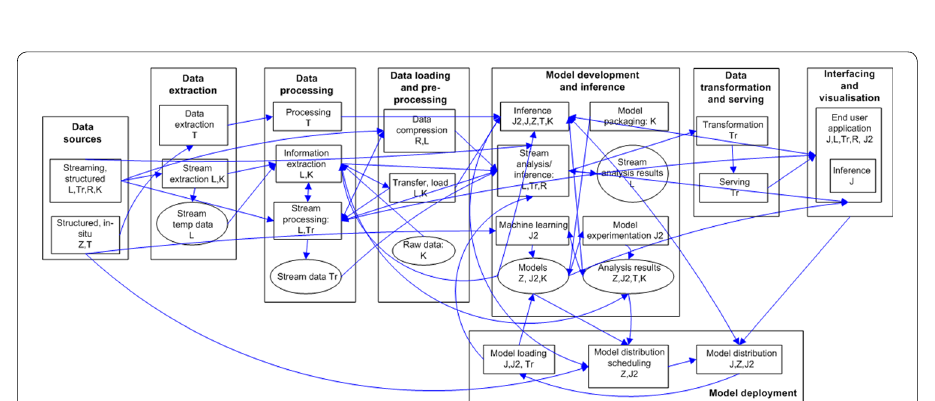
Fig. 22 Mapping of all inference-related implementation architectures to the big data RA. Publications are referred to from the architectural elements as follows: L: Liu [29]; Tr:Trinelli [32]; R:Ran [34]; Z:Zhou [31]; T:Teera